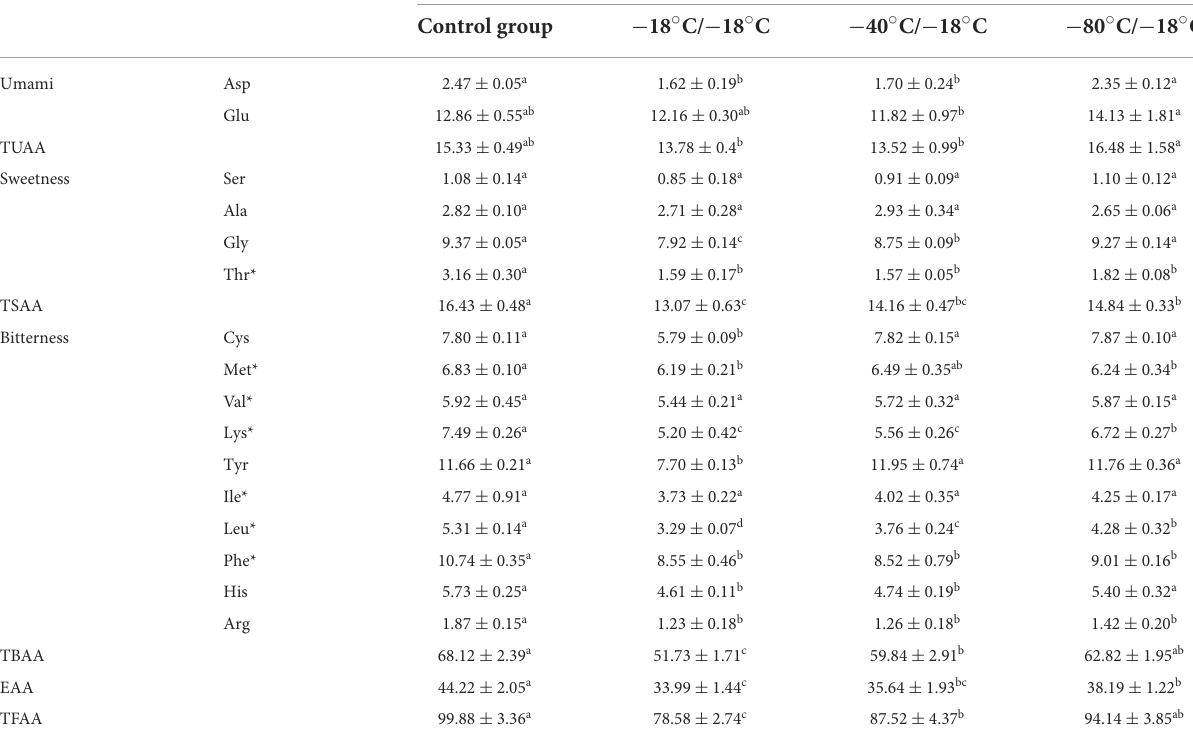
TABLE 4 Free amino acids of HGM with different freezing rates.